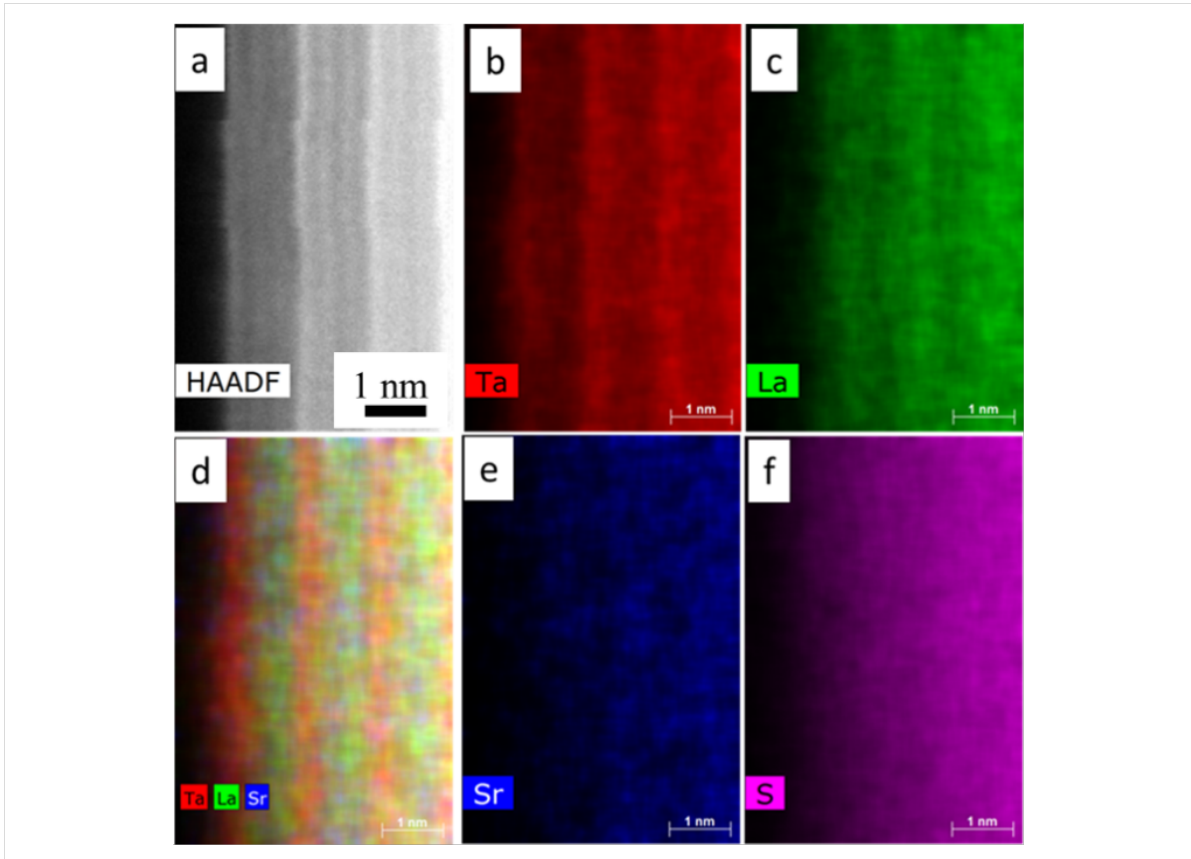
Figure 7: (a) HAADF-STEM image and (b–f) EDX elemental mapping on a Sr x La 1 − x S–TaS 2 (40 atom % Sr in the precursor) nanotube of (b) Ta, (c) La, (d) a composite map of the elements, (e) Sr and (f) S.